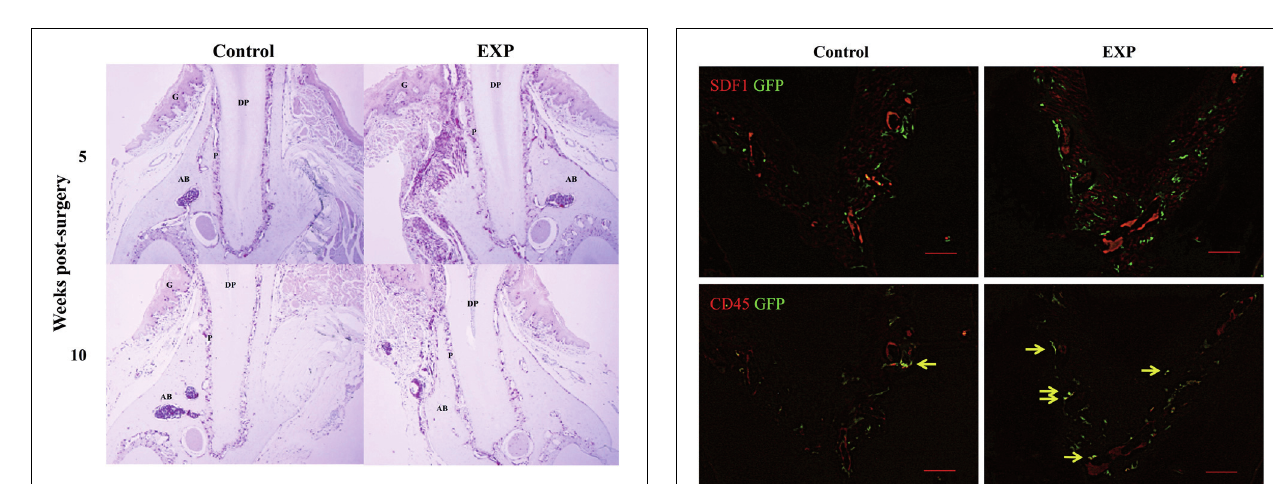
FIGURE 1 | Localization of GFP-positive cells in intact periodontal tissue. Visualization of BMCs in vivo on periodontal tissue. Arrows indicate osteoclast-like multinucleated giant cells (A) and macrophage-like cells in gingival epithelium (B) were GFP-positive, implying that GFP-positive images were confirmed to match BMCs. GFP-positive cells were also observed at